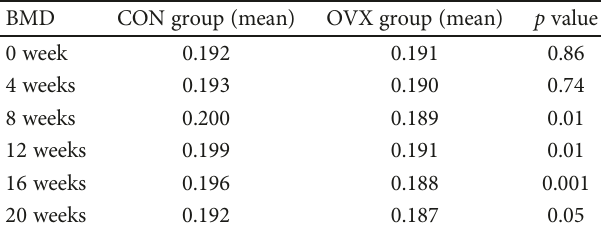
Figure 7: Bone mineral density by period from week 0 to week Table 1: Comparisons of femur mean bone densities in animal model.